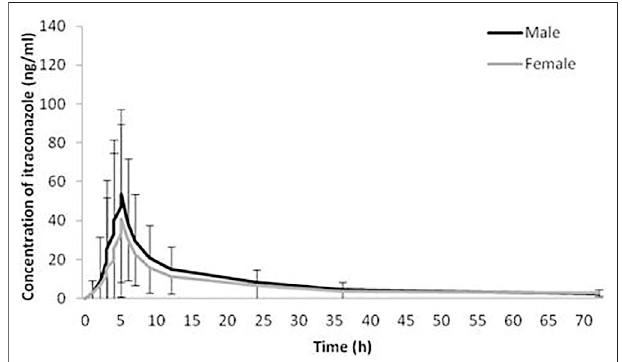
FIGURE 1 | Plasma concentration-time curves. Geometric mean and standard deviation of itraconazole plasma concentrations over time after a single oral dose of 100 mg of itraconazole in 114 analyzed sets of plasma concentrations, 66 obtained from male and 48 from female healthy Caucasian